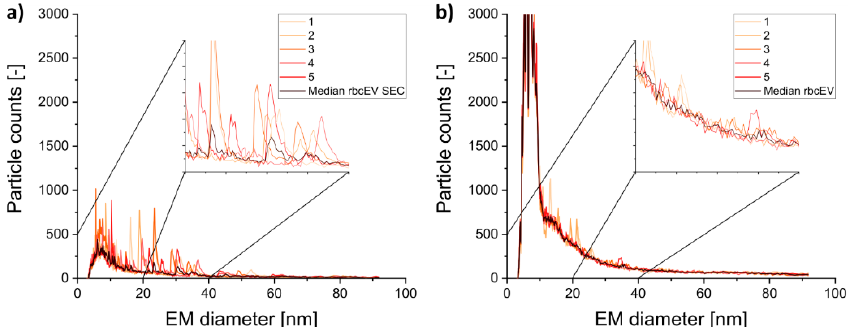
Figure 4. Comparison of nES GEMMA spectra of five single measurements and their median of rbcEV ± SEC purification, respectively. Measurements of rbcEV + SEC ( a ) reveal a significantly increased signal noise in contrast to rbcEV ( b ).